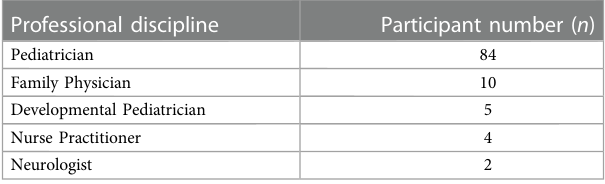
TABLE 1 Professional disciplines of ECHO Ontario Autism